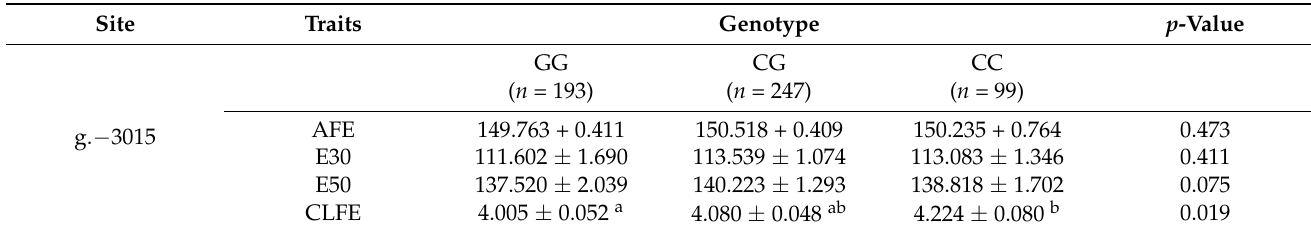
Table 3. Associations of the SNP genotypes with laying traits in the Jining Bairi chicken. Site Traits